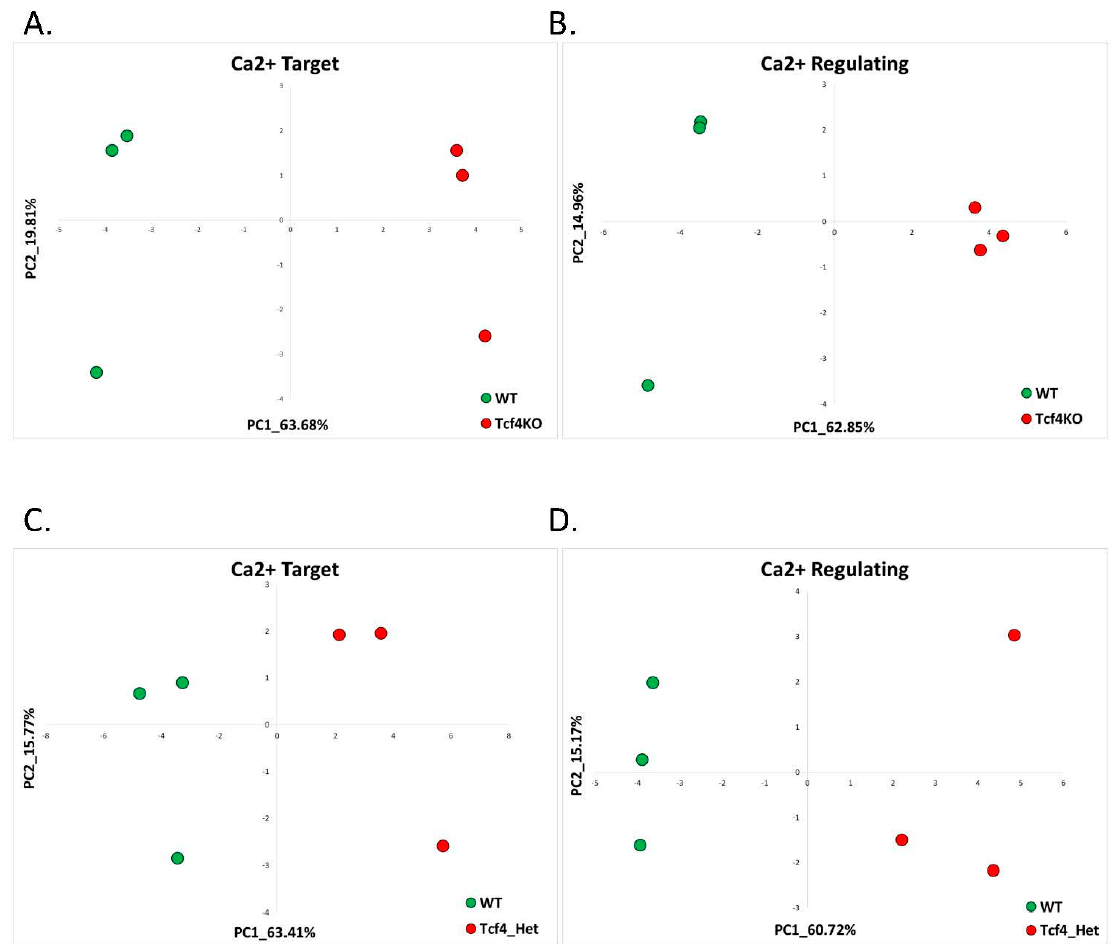
Figure 3. Pitt-Hopkins: ca-target and ca-regulating signatures. ( A ) PCA based on the expression of calcium-target signature genes in dorsal telencephalons of Tcf4 Knockout (Tcf4-KO) compared to control (WT) mice. The control samples are denoted in green, while the Tcf4 Knockout samples are in red. ( B ) PCA based on the expression of calcium-regulating signature genes in dorsal telencephalons of Tcf4 Knockout (Tcf4-KO) compared to control (WT) mice. The control samples are denoted in green, while the Tcf4 Knockout samples are in red. ( C ) PCA based on the expression of calcium-target signature genes in dorsal telencephalons of Tcf4 Heterozygous (Tcf4-Het) compared to control (WT) mice. The control samples are denoted in green, while the Tcf4 Knockout samples are in red. ( D ) PCA based on the expression of calcium-regulating signature genes in dorsal telencephalons of Tcf4 Heterozygous (Tcf4-Het) compared to control (WT) mice. The control samples are denoted in green, while the Tcf4 Knockout samples are in red.